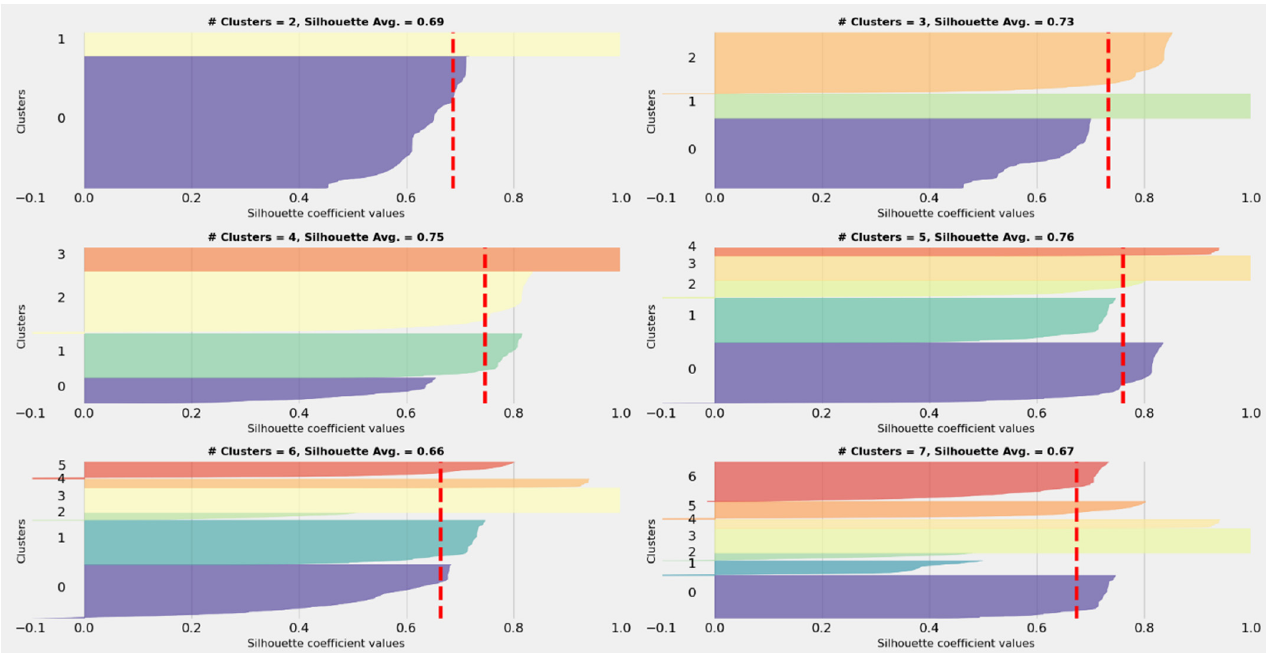
Figure 4. Hierarchical clustering dendrogram for IEEE-24 bus dataset.